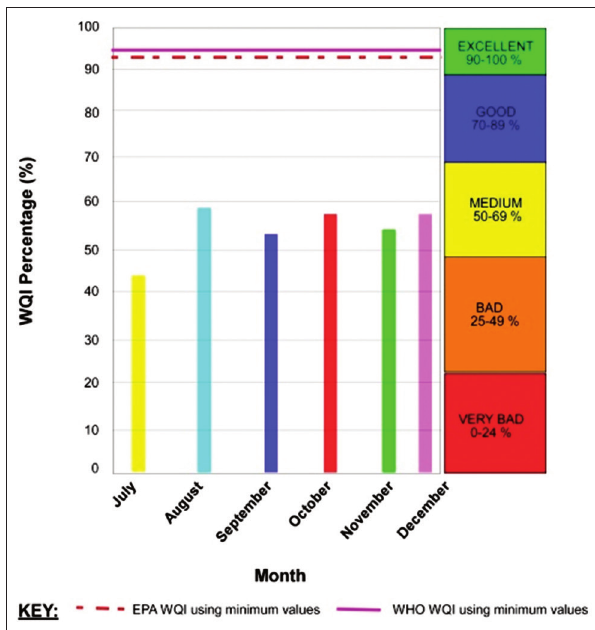
Figure-2: Average monthly water quality indices compared to the United States Environmental Protection Agency water quality index calculated using minimum values for drinking water standards for human